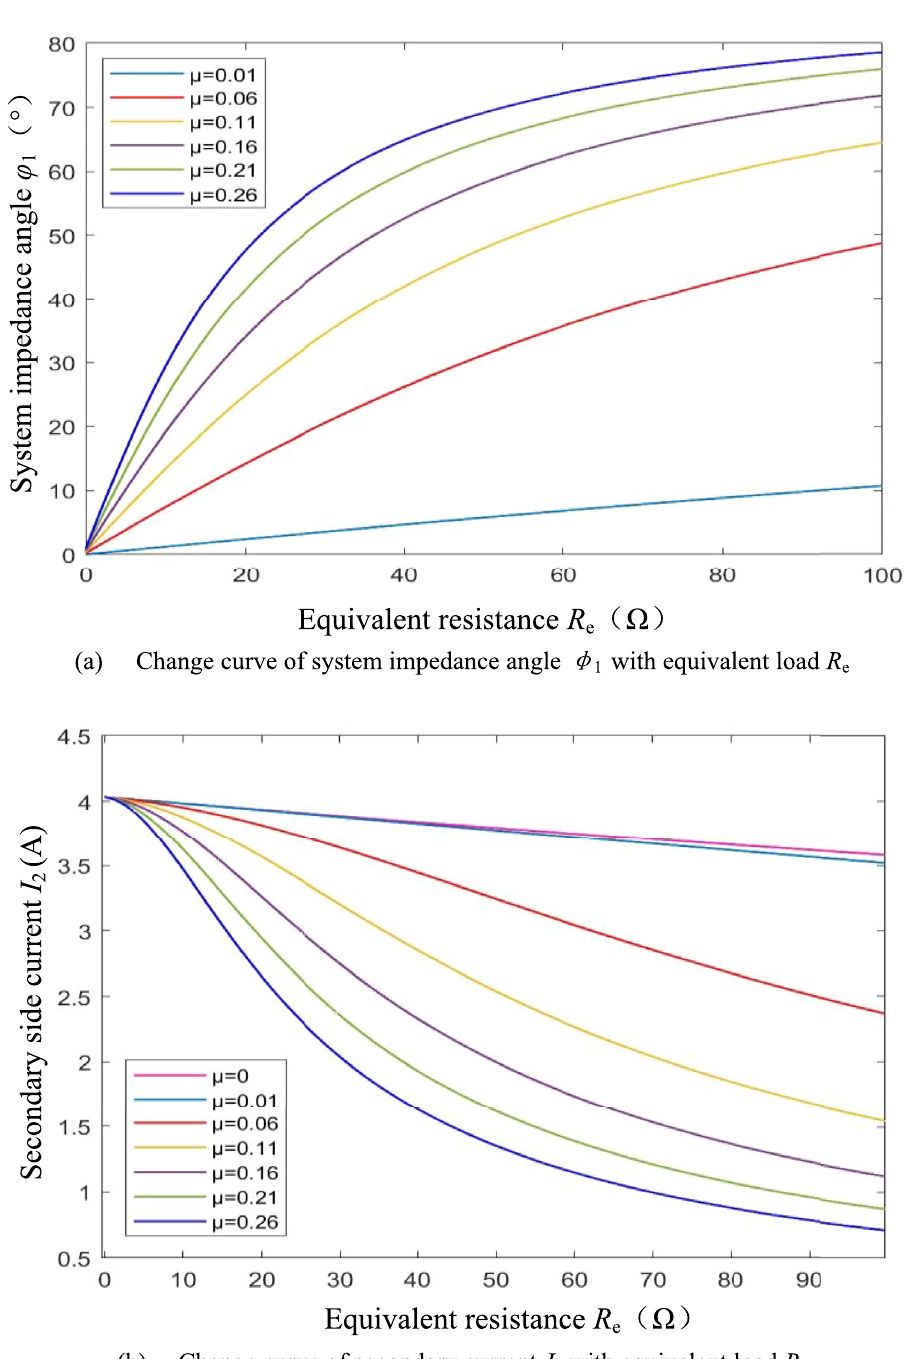
Figure 5. System impedance angle and secondary current when the primary side is